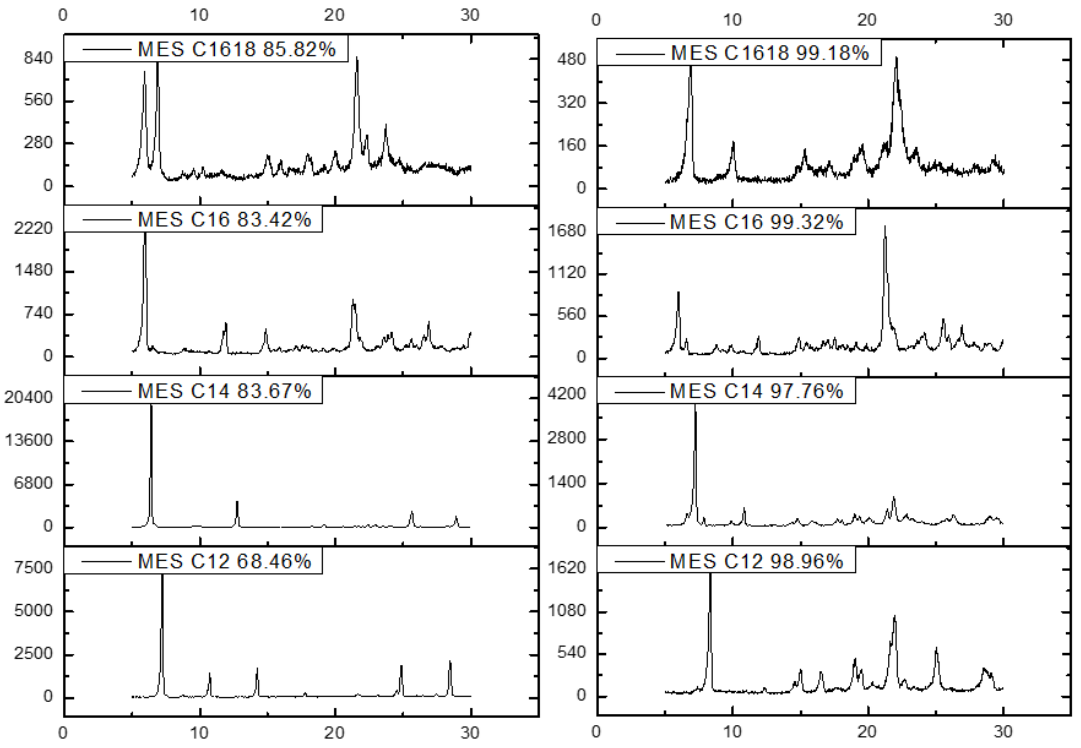
Figure 8. X-ray di ff raction (XRD)-histograms of MES C 12 , C 14 , C 16 and C 16–18 before (left) and after Figure 8. X-ray diffraction (XRD)-histograms of MES C 12 , C 14 , C 16 and C 16-18 before (left) and after crystallization crystallization (right).